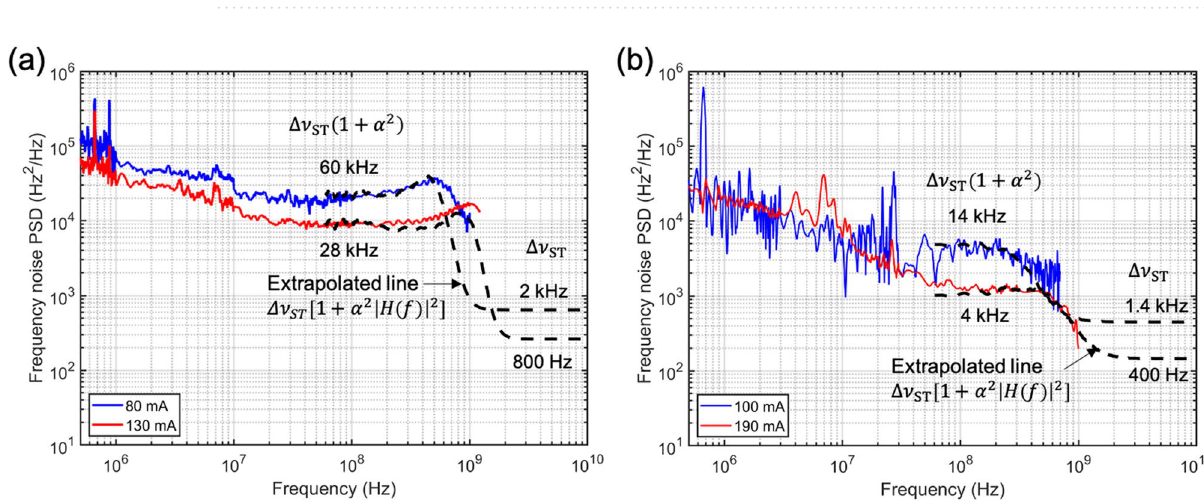
Figure 5. The frequency noise power spectral density of the lasers. The expected frequency noise at frequencies further into the GHz range is extrapolated in black dotted line using Eq. (9). ( a ) The 50 nm QNCL laser 1577 nm , α 5.8 ). ( b ) The 90 nm QNCL laser ( I th 50mA , (cid:31) 0 ( I th = = =